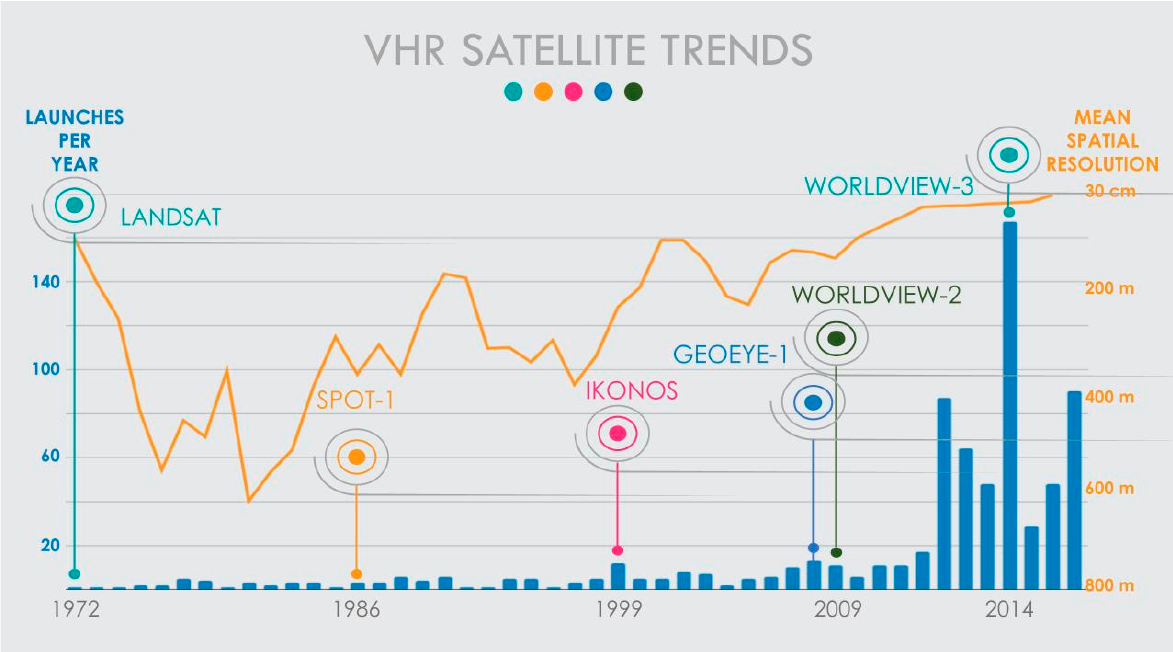
Figure 2. Trends in earth observation very high-resolution (VHR) satellites launched since 1972 by commercial and government providers (excluding military), showing the number of satellites launched per year on the left vertical axis and the mean spatial resolution on the right vertical axis. Adapted with permission from [10]. See Supplementary Materials S1 for the underlying data.